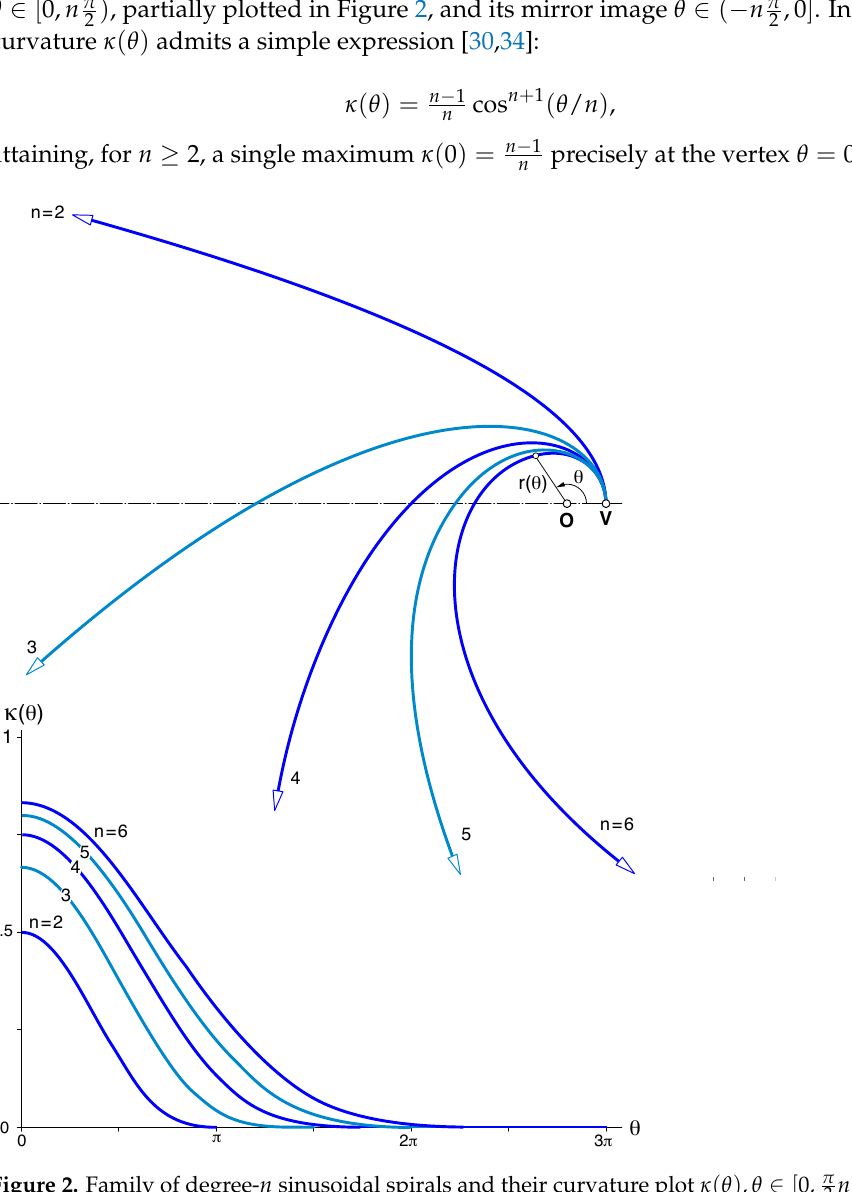
Figure 2. Family of degree- n sinusoidal spirals and their curvature plot κ ( θ ) , θ ∈ [ 0, π